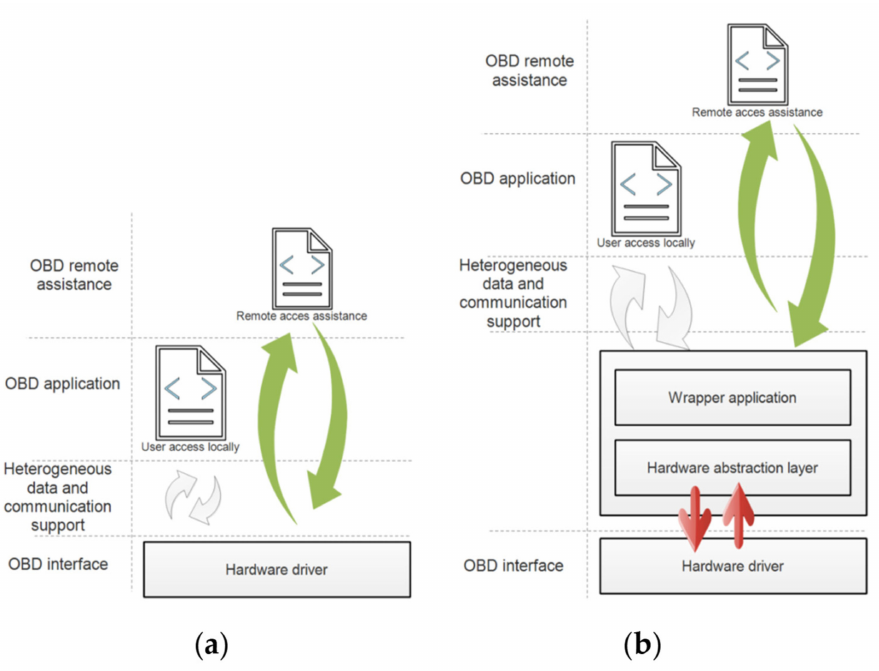
Figure 4. Designed architecture of a three-layer model for communications between services and data: managed directly ( a ) or through a mediator ( b ) by the hardware